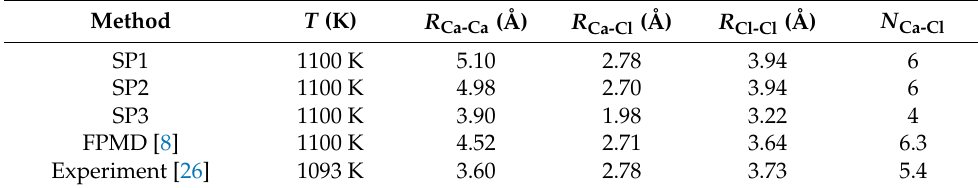
Figure 1. The radial distribution function of ( a ) Ca-Cl, ( b ) Cl-Cl; and ( c ) coordination number distribution in CaCl 2 calculated with different potential parameters. Table 2. The first peak positions R of ions pairs of CaCl 2 and averaged coordination number N of molten CaCl 2 [8,26].